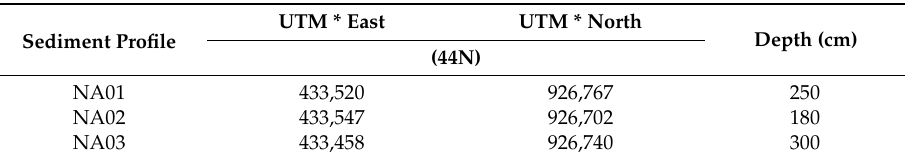
Table 2. Drilling characteristics.